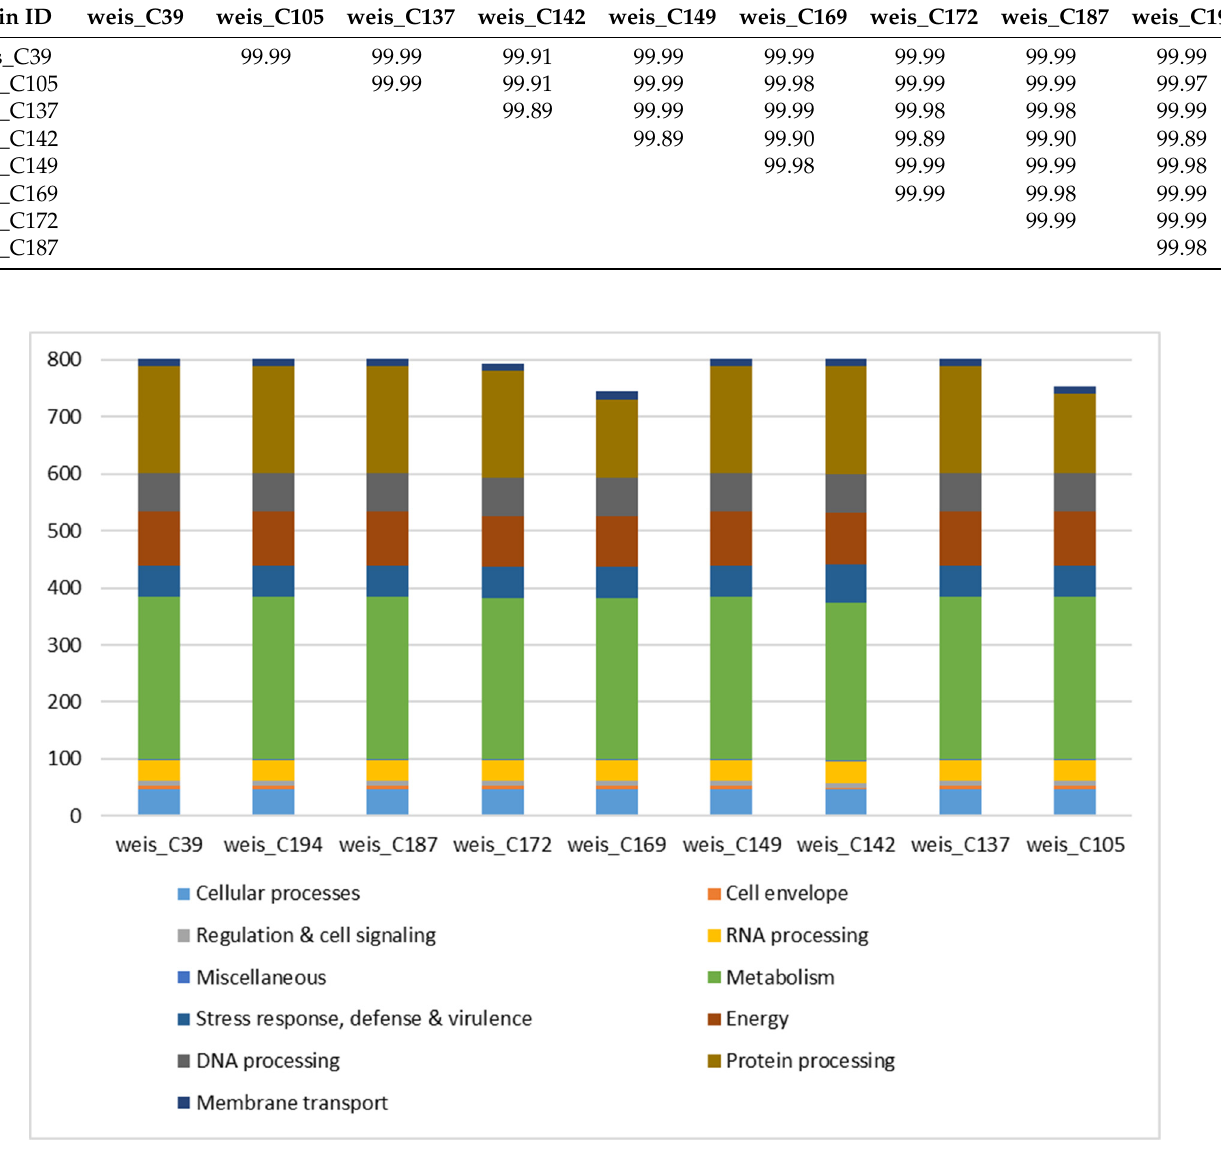
Figure 1. Overview of the subsystems in Weissella paramesenteroides genomes. Table 1. Species identification and assembly statistics for the nine W. paramesenteroides isolates.